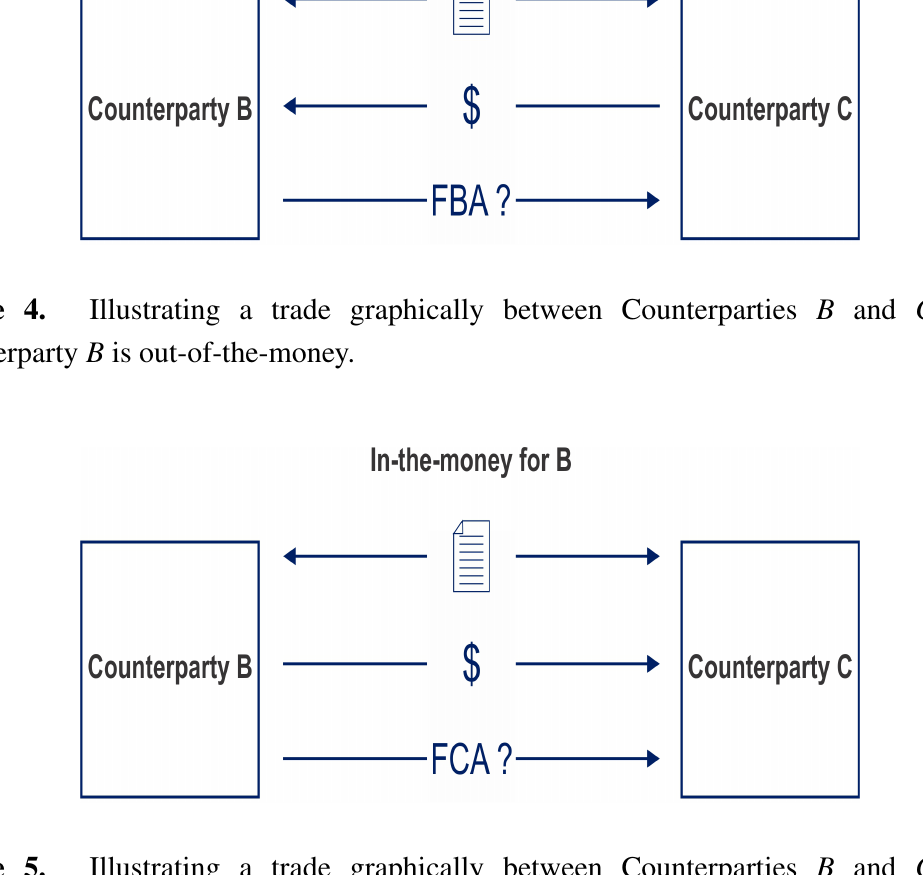
Figure 5. Illustrating a trade graphically between Counterparties B and C when Counterparty B is